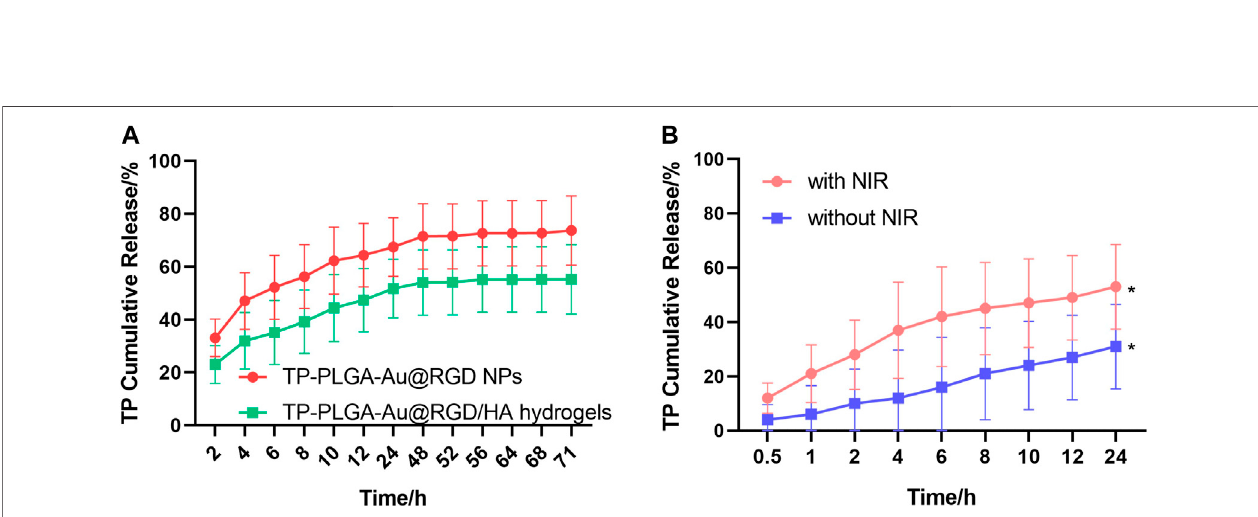
FIGURE4 |(A) Temperature curves ofTP-PLGA-Au@RGD/HA hydrogels (808 nm). (B) Temperature evolution ofTP-PLGA-Au@RGD/HA hydrogels over 4on-off cycles with 808 nm laser irradiation. (C) Thermal images of TP-PLGA-Au@RGD/HA hydrogels under 808 nm laser irradiation at different time points.